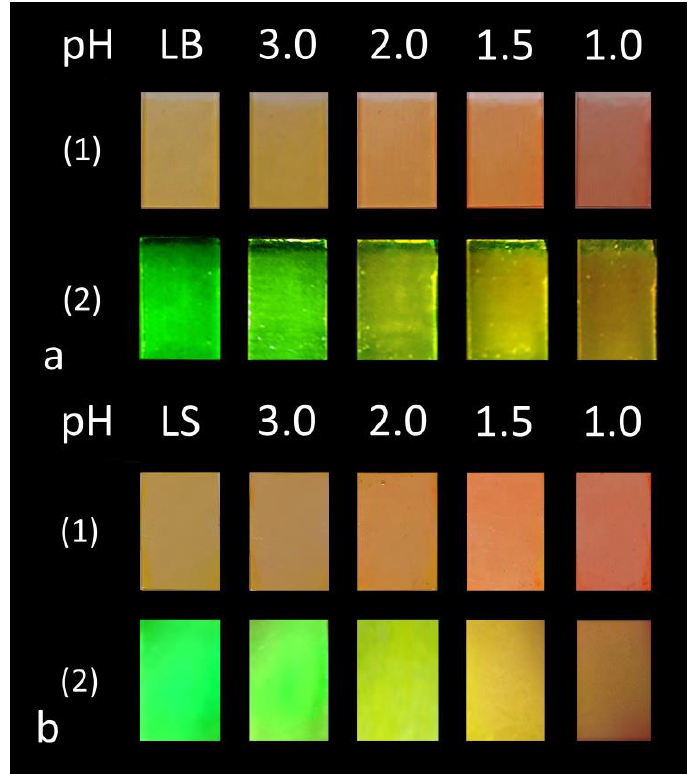
Figure 9. pH-induced color changes of 30-layer LB ( a ) and LS ( b ) films of QC8 ( 1 ) in daylight and ( 2 ) under irradiation by LED ( λ = 365 nm).